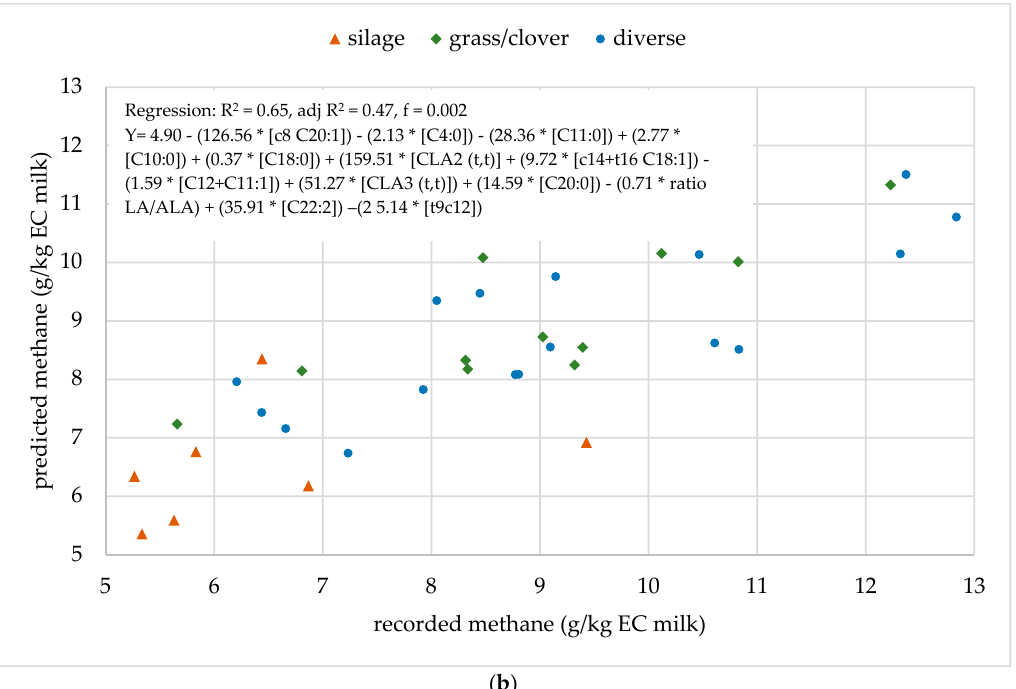
Figure 2. Measured vs. predicted methane output ( a ) per day and ( b ) per kg energy-corrected milk yield, coded according to forage type .